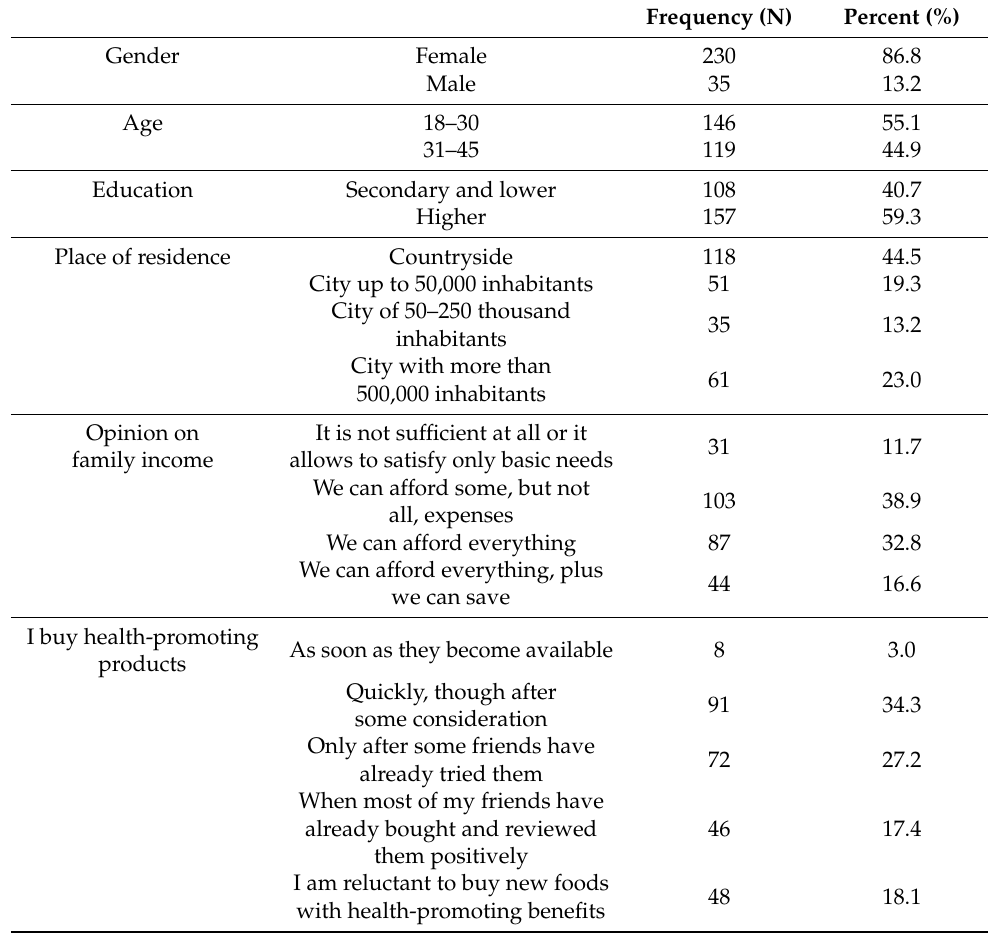
Table 1. Socio-demographic characteristics of the study sample (N;